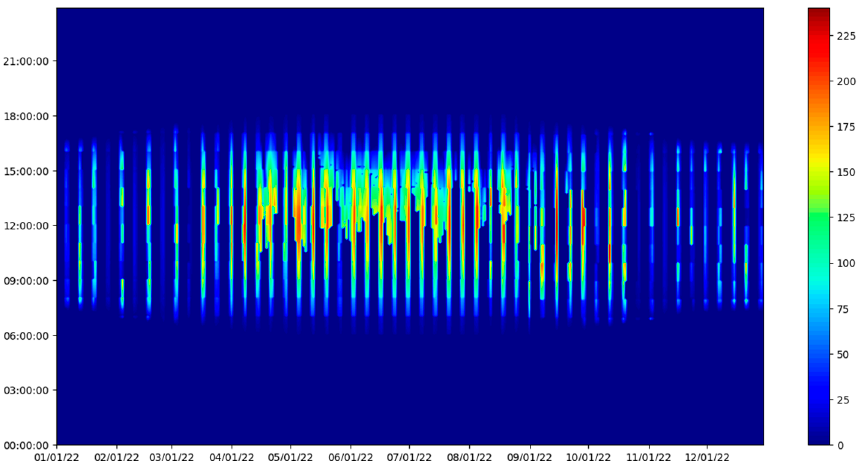
Figure 12. Power exported to grid (kW) as function of the day (horizontal axis) and the hour of day (vertical axis).